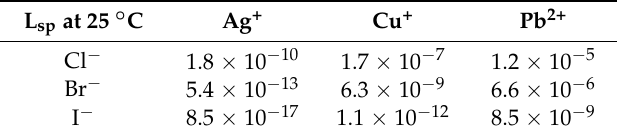
Table 2. Solubility product of salts at 25 ◦ C [11].